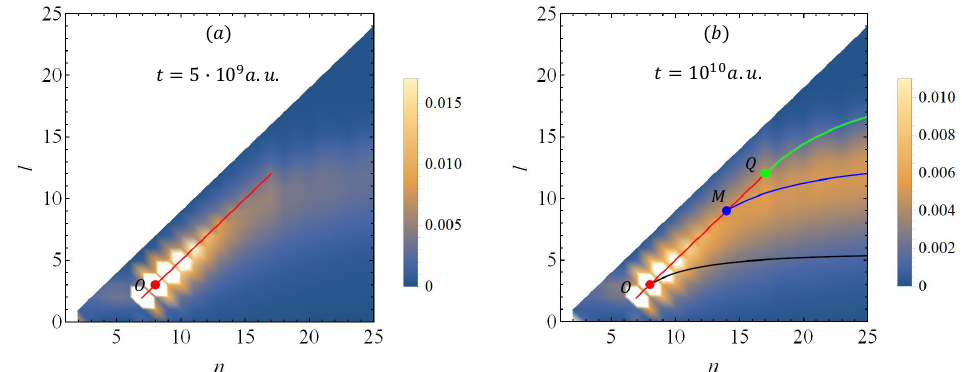
Figure 1a: The population propagates along the straight (red) line. Figure 1b: The population spreads over a region approximately constrained by well-